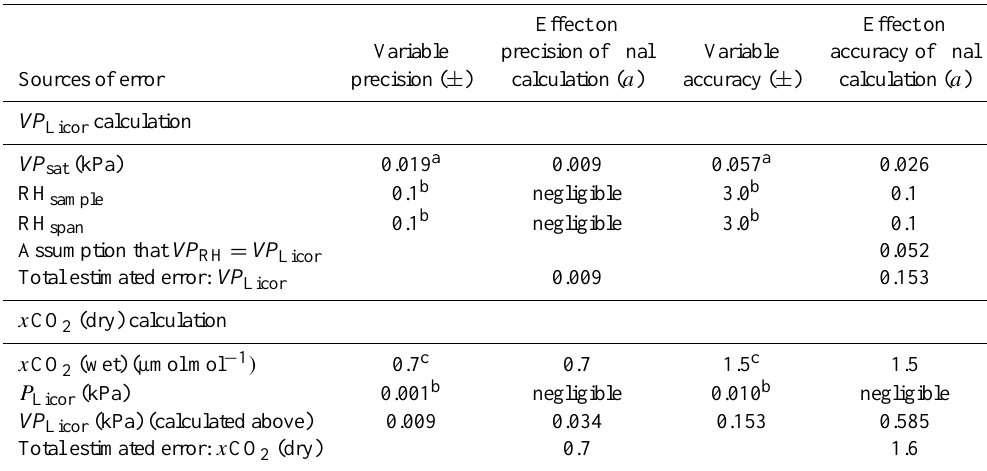
Table 3. Sources of error for the calculation of x CO 2 (dry) at atmospheric pressure = 101kPa, RH sample = 75%, RH span = 30%, SST = 25 ◦ C, SSS = 35, and x CO 2 (wet) = 375µmolmol − 1 . Total estimated precision and accuracy are calculated using the root-sum- (cid:16) P (cid:17) 1 / 2 a 2 of-squares method (RSS): RSS = .